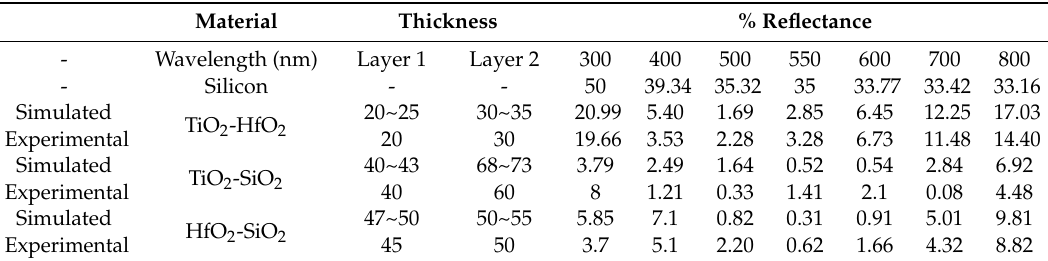
Table 2. Simulation parameters for modeling composite bilayer AR coatings.